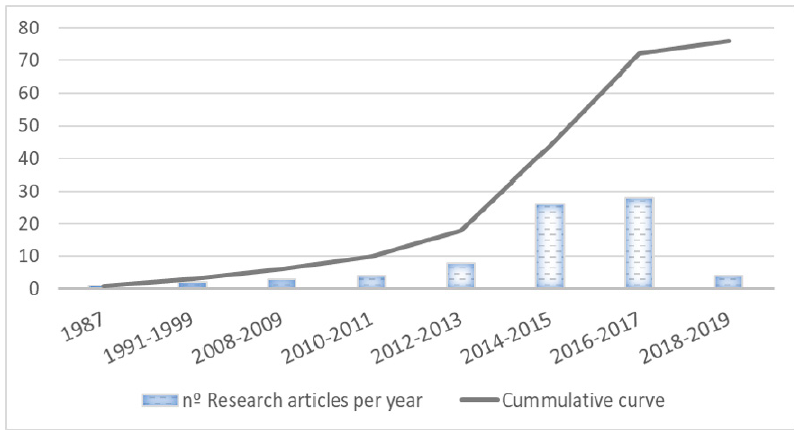
Figure 3. Trend graph of the number of research articles per year in recent year.